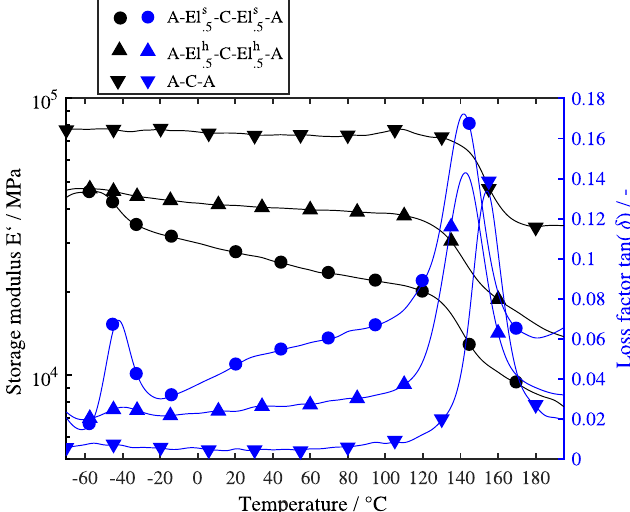
Figure 7. 3PB Temperature sweep at 1Hz for all lay-ups with aluminum on the outside. The solid lines are fitted to the measurement steps every 2.5 ◦ C from − 70 ◦ C to +200 ◦ C and every 5 ◦ C from − 20 ◦ C to 200 ◦ C. For better visibility, only a few markers are displayed.